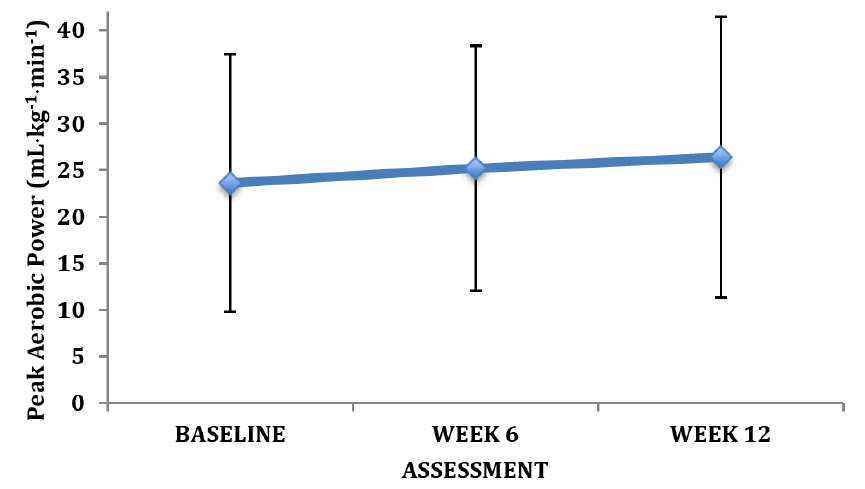
Figure 2. Changes in peak aerobic power with exercise intervention (mean ± SD).